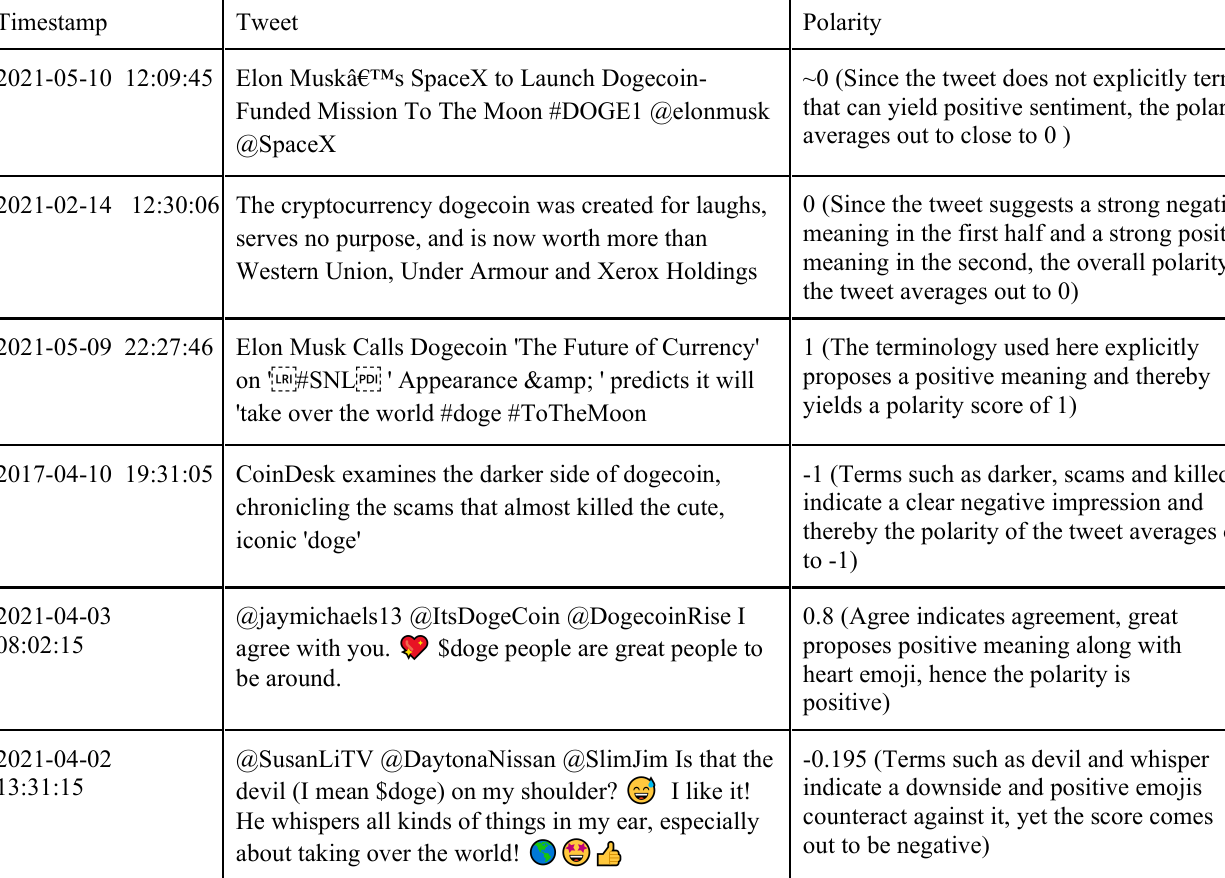
Table 3. Sample Tweets related to the Dogecoin